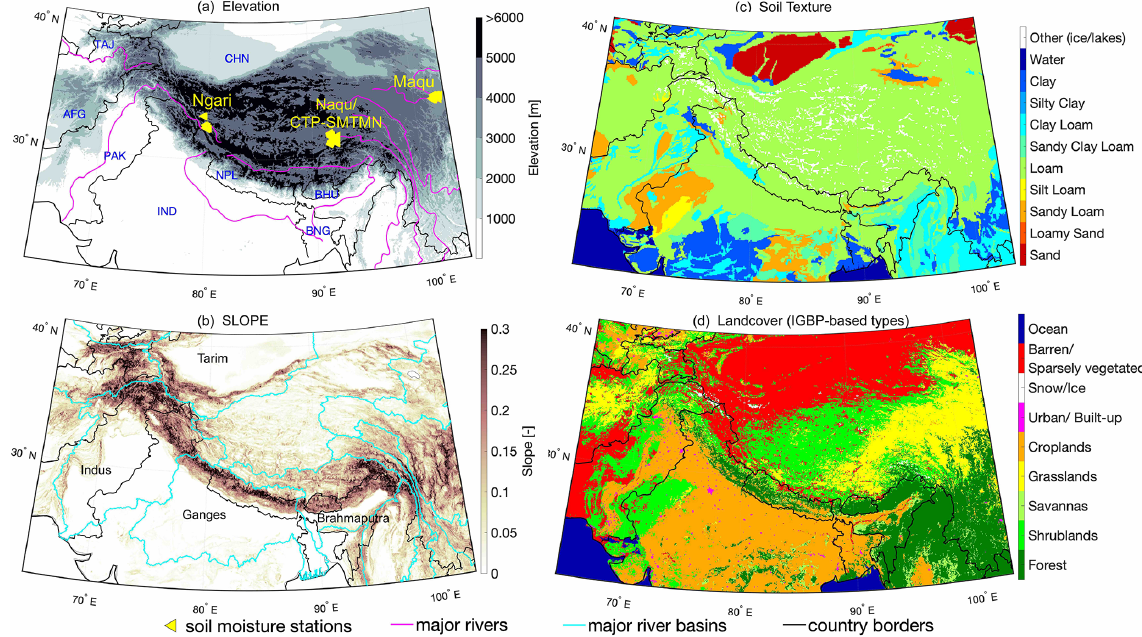
Figure 1. The study domain encompasses the mountainous region in South Asia and the adjoining areas. High-elevation and high slope ( > 0 . 2) areas demarcate the Hindu Kush–Himalayan mountain range, whereas the high-elevation and mild-slope ( < 0 . 1) grid cells demarcate the Tibetan Plateau ( a and b ). The yellow markers in (a) locate the stations within the Tibetan Plateau used to evaluate the soil moisture estimates (Sect. 4.1). The domain soil texture was categorized into 11 soil types ( c ) according to the NCEP/STATSGO+FAO classification. The domain land cover comprised 10 main types based on the MODIS-derived IGBP classification ( d ). AFG is Afghanistan, BNG is Bangladesh, BHU is Bhutan, CHN is China, IND is India, NPL is Nepal, PAK is Pakistan, and TAJ is